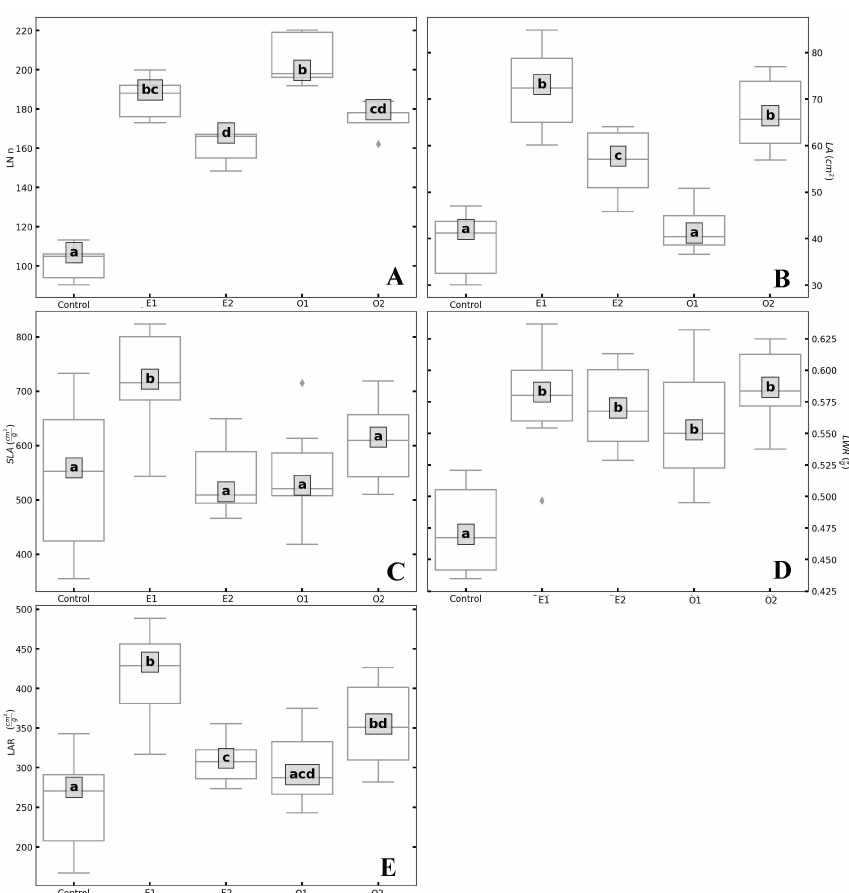
Figure 4. Box plots representing the variation in leaf parameters at the end of the experiment, for: ( A ) leaves number, ( B ) leaf area, ( C ) Specific Leaf Area, ( D ) Leaf Weight Ratio and ( E ) Leaf Area Ratio, of Tanacetum balsamita plants in response to the application of EM and OMW biostimulants at two different concentrations. The central line displays the median, the bottom and top of the box are the first and third quartiles. Different letters indicate significant differences ( p < 0.05) using the Tukey’s